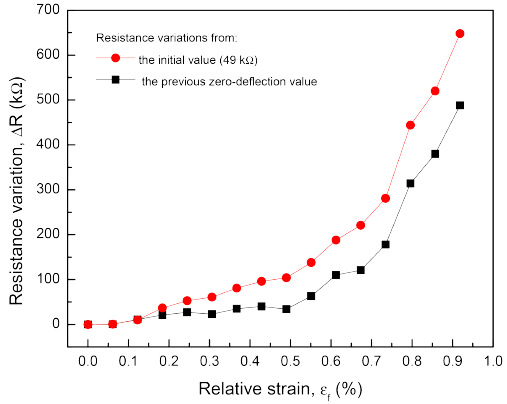
Figure 7: Electrical resistance, R , measured at different maximum deflection values